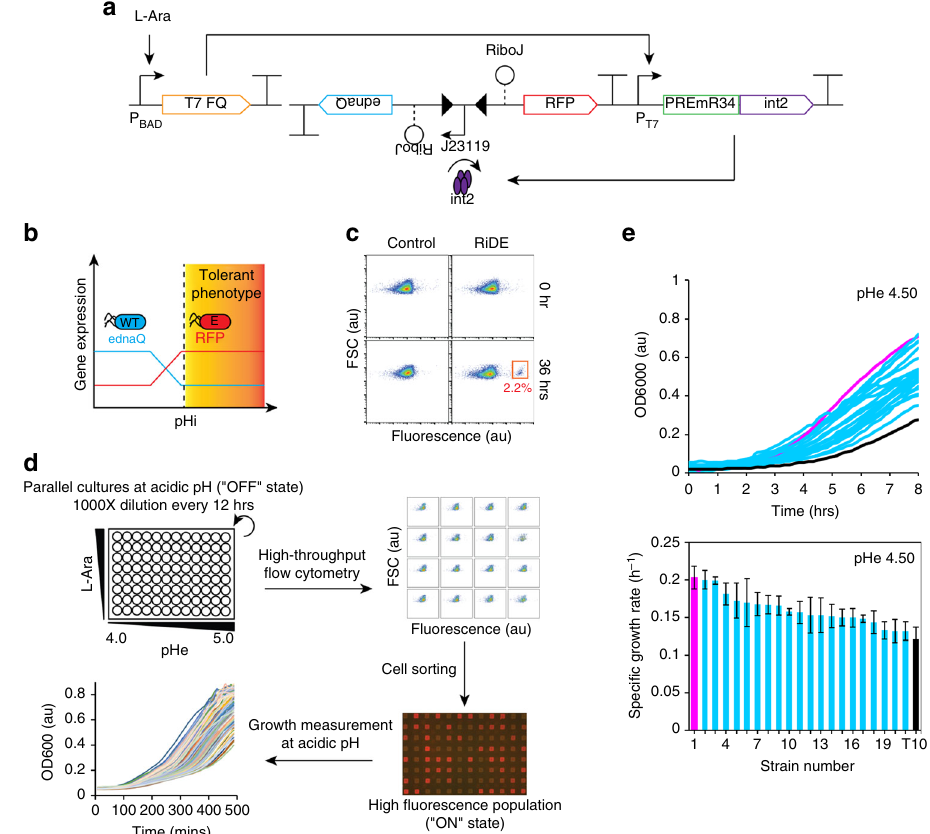
Fig. 4 Programming autonomous evolution of acid-tolerant phenotypes. a Schematic of a genetic platform that enables the self-directed evolution of an acid-tolerant phenotype (RiDE). b Conceptual design of RiDE. A core pH-sensing module was employed to determine the single-cell pHi. In the default con fi guration, RiDE sets host cells to a rapidly evolving state and generates genetic heterogeneity among the progeny population. Mutants that evolve to stably maintain the pHi near neutrality activate integrase expression, which then inverts the J23119 promoter to turn OFF in vivo mutagenesis and turn ON RFP expression. c Flow analysis of RiDE culture after 36 h of growth. A small population of a highly fl uorescent evolved phenotype is boxed in red . d High-throughput experimental work fl ow to isolate acid-tolerant phenotypes from RiDE-based evolution experiment. For each of 16 combinations of pHe (4.0, 4.5, 4.8, 5.0) and L -arabinose (0.0001%, 0.001%, 0.002%, 0.02% m/v), three biological replicates were prepared to form a total of 48 parallel cultures. As negative controls, cells transformed with digitalized pH-sensing system (without ednaQ expression) were used to prepare another 48 parallel cultures with similar pHe and L -arabinose conditions. RFP expressions in the parallel cultures were monitored by a robotic fl ow analyzer every 12 h.